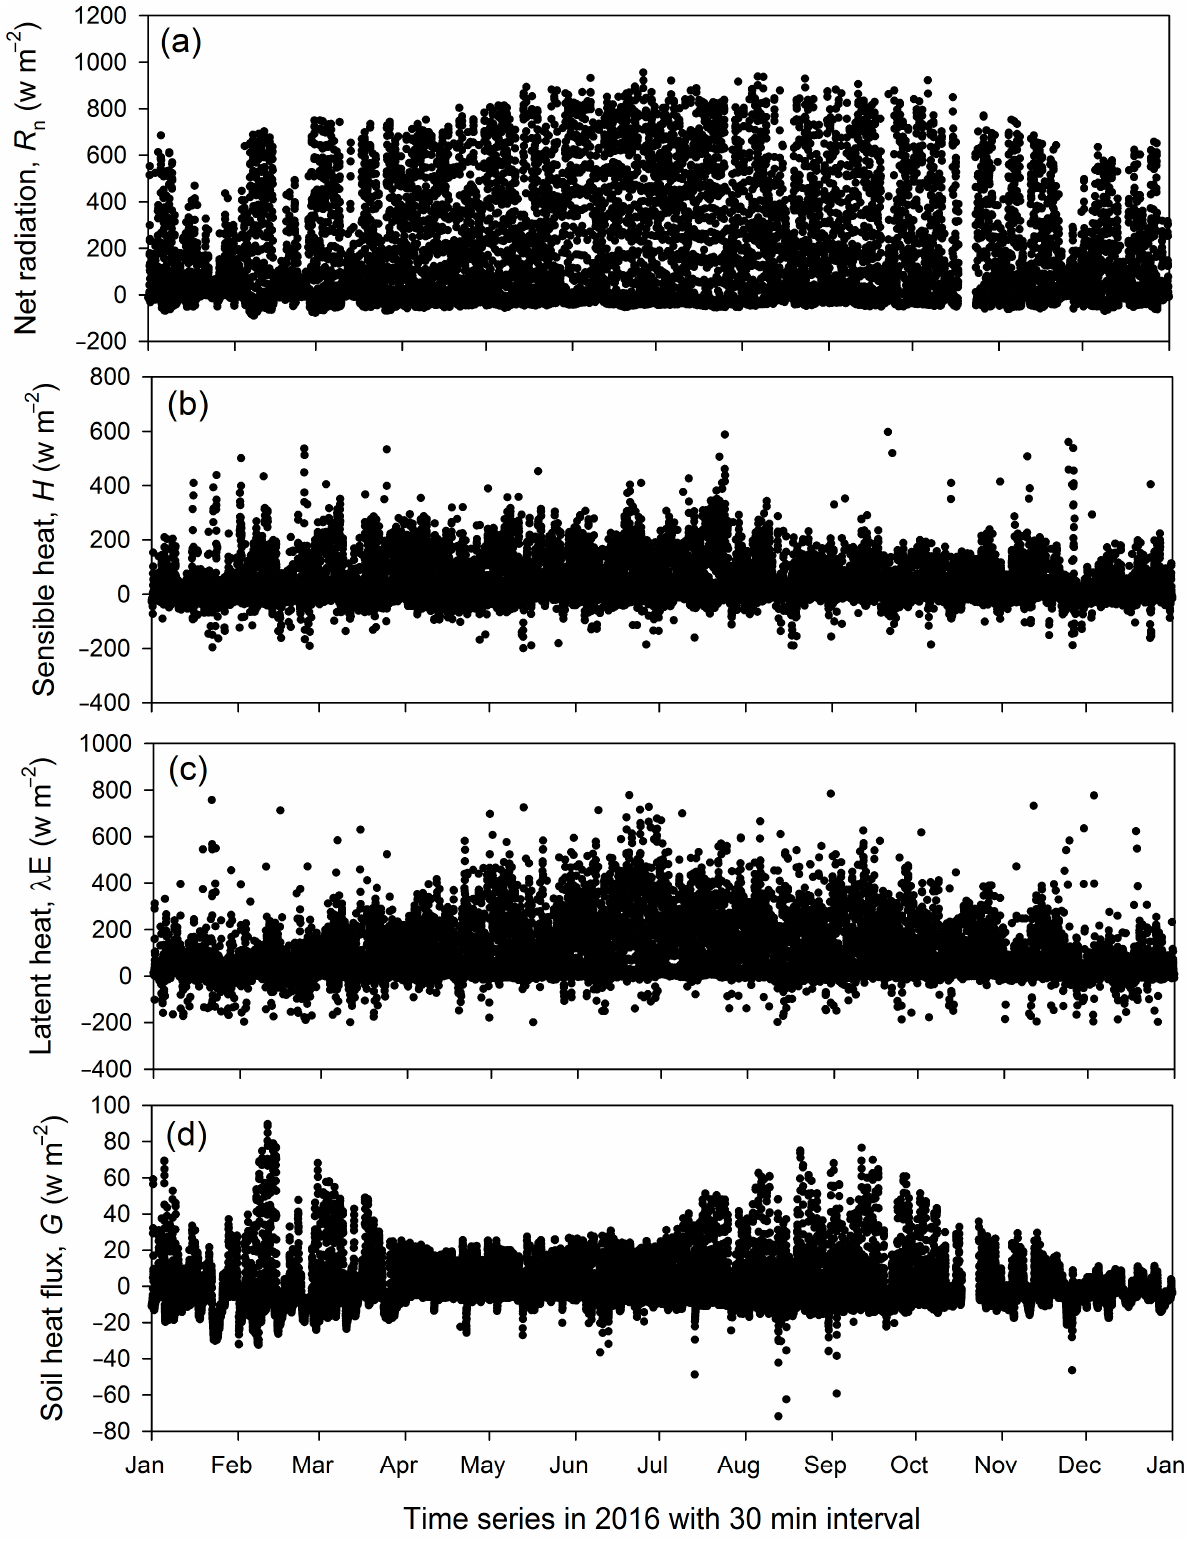
Figure 3. Net radiation ( a , R n ), Sensible heat ( b , H ), Latent heat ( c , λ E ), Soil heat flux ( d , G ). Time series of energy fluxes as observed by the eddy flux tower. The figure shows 30 min intervals for one-year data collected in 2016. No gap filling was performed.